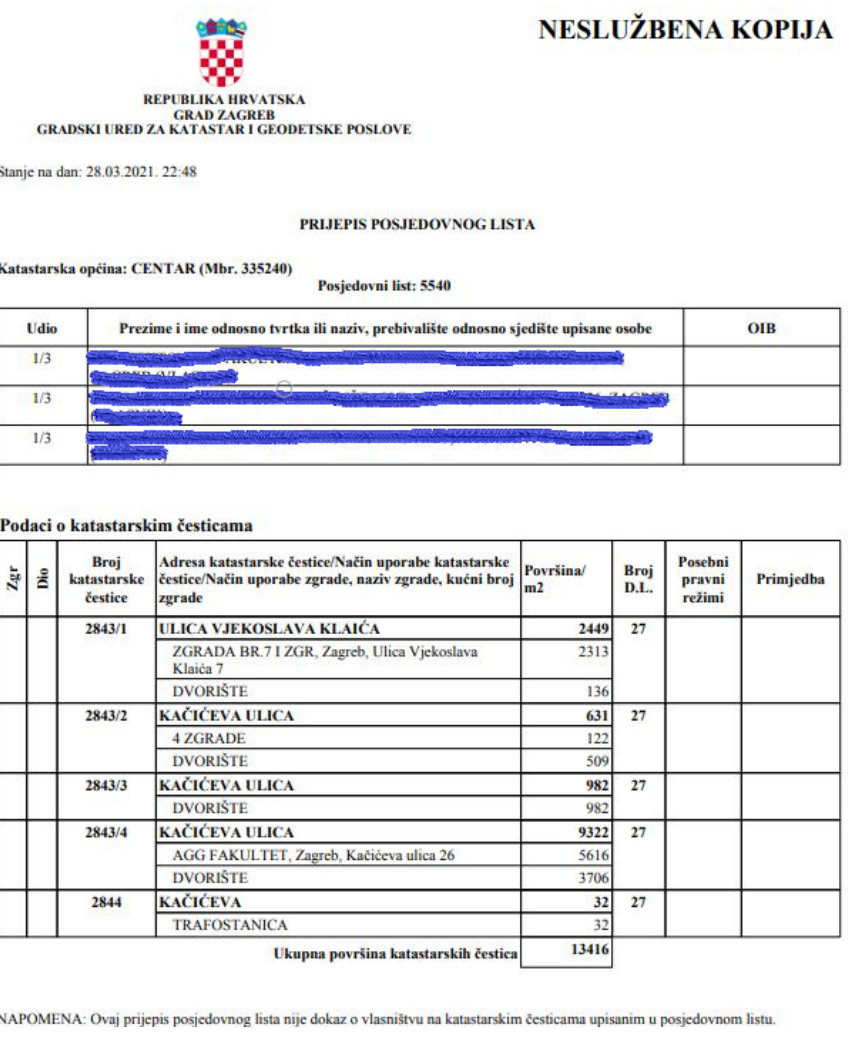
Figure 4. Possessory sheet transcript. Source: [29].